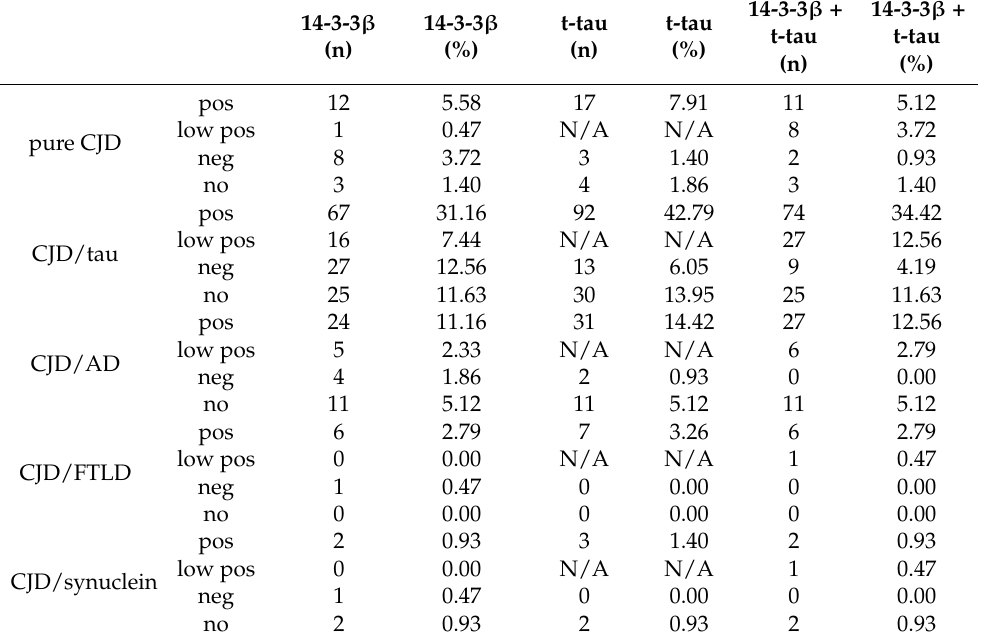
Table 3. Numbers (n) and percentage (%) of positive, low positive, negative and unanalysed results of the presence of 14-3-3 β , t-tau levels and the combined presence of 14-3-3 β and t-tau protein levels in CSF. Percentage is related to the whole